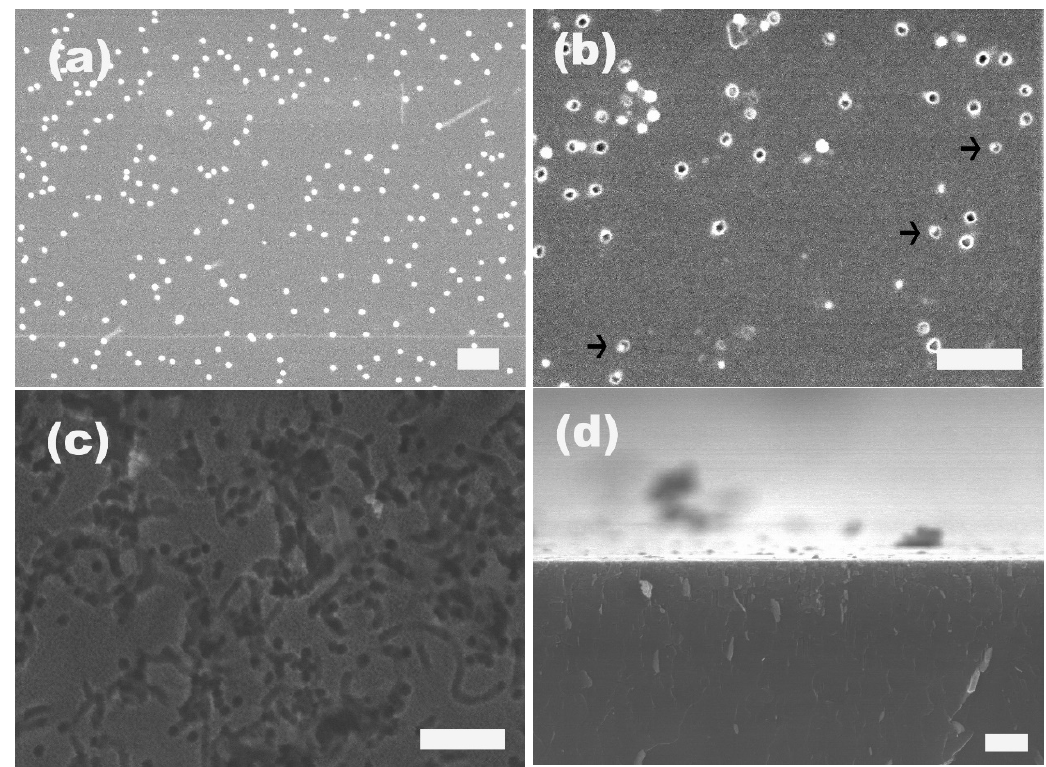
Figure 6. SEM images of Si surface after etching in the presence of 20 nm gold particles for ( a ) 30 s; ( b ) 60 s; ( c ) 5 min; and ( d ) is the cross-sectional SEM image of ( c ). The scale